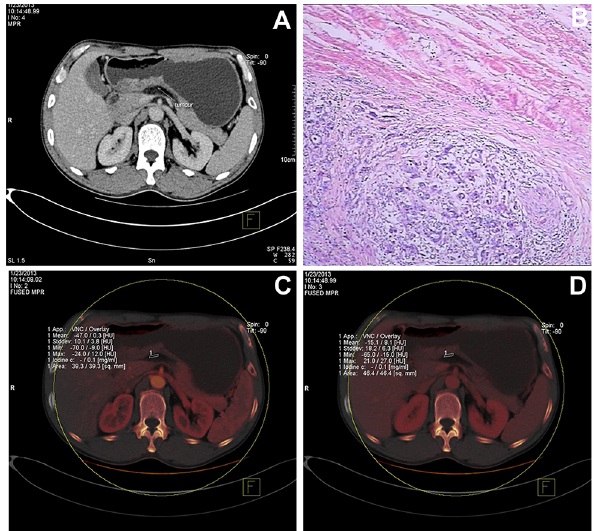
Fig 2. Representative CT images obtained from a 46 year-old male patient. (A) The mixed venous phase image depicts thickening of the wall of the antrum with transmural enhancement. The density of the perigastric fat was elevated, with a stripe-like shadow. The clinical stage was determined to be cT4. (B) The histological image, stained with hematoxylin and eosin (HE, ×100), revealed a grade II adenocarcinoma with muscularis invasion. The pathologic stage was pT3. (C) The iodine map at the arterial phase shows that the iodine concentration was 0.1 mg/mL in the perigastric fat (ROI 1). (D) The iodine map at the venous phase shows that the iodine concentration was 0.1 mg/mL in the perigastric fat (ROI 1).